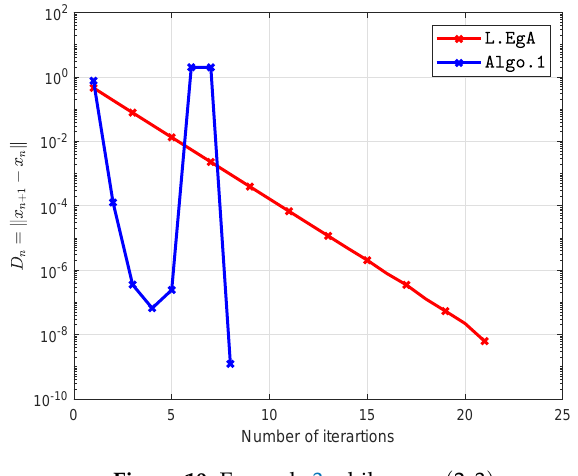
Figure 10. Example 3 while u 0 = ( 2,3 ) .